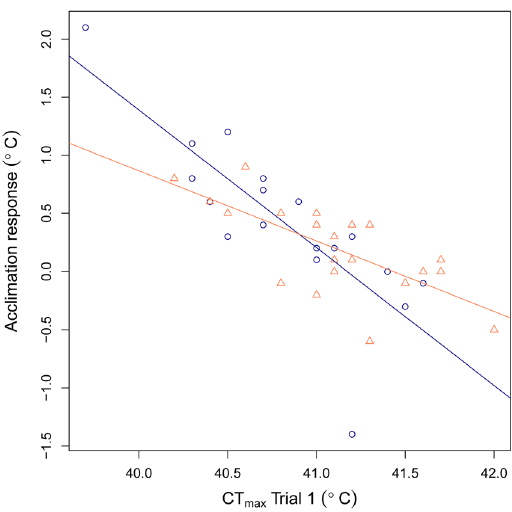
Figure 2. The relationship between an individual fish’s initial or innate CT max (Trial 1) and their acclimation response (change in CT max from Trial 1 to Trial 2) (n = 40). There was a one week interval between Trial’s 1 and 2 and a thermal ramping of 0.3 °C min − 1 was used to determine CT max . Females are represented by orange triangles and an orange regression line and males by blue circles and a blue regression